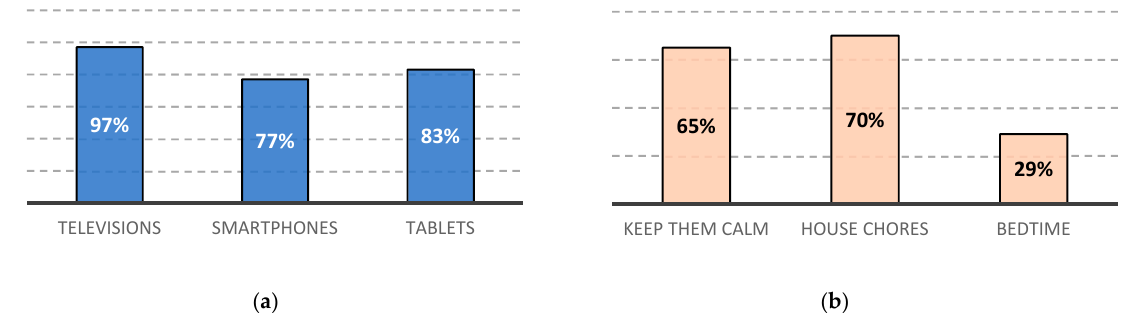
Figure 5. ( a ) Household media (%); ( b ) smartphone usage for three class of ages (%).